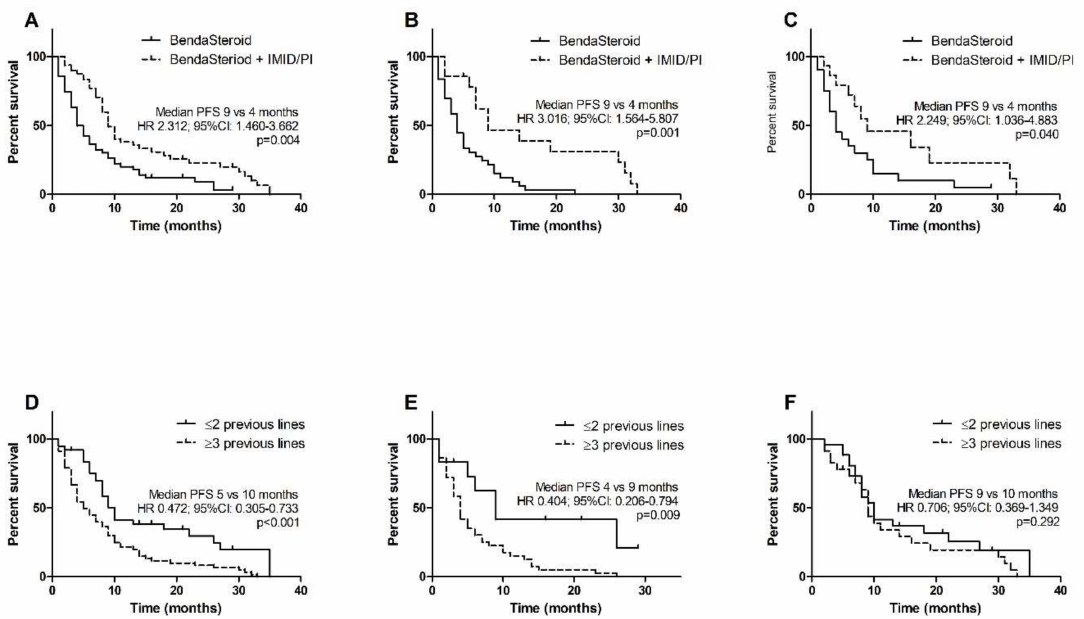
Figure 1. Kaplan–Meier estimates of progression-free survival (PFS): ( A ) all patients; ( B ) subgroup of patients previously treated with lenalidomide and bortezomib; ( C ) subgroup of patients after ASCT; ( D ) impact of previous therapies number in all patients; ( E ) impact of previous therapies number in patients treated with bendamustine and steroid; ( F ) impact of previous therapies number in patients treated with bendamustine, steroid and